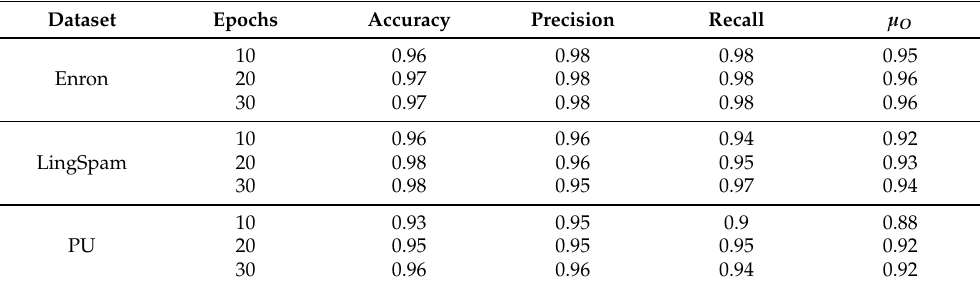
Table 5. Results for testing data for different datasets using the LSTM model.